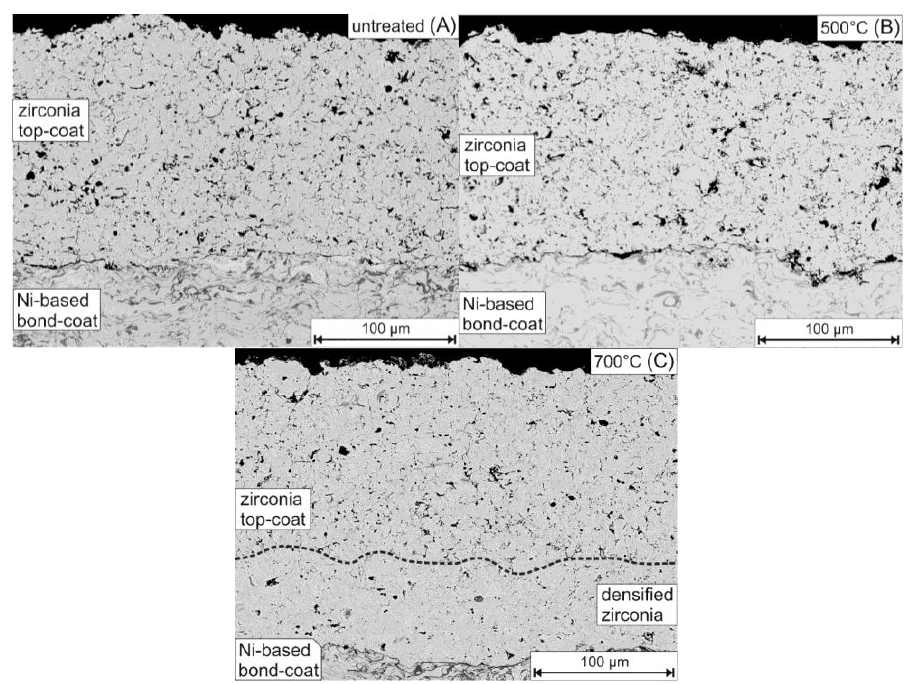
Figure 7. Back-scattered electron images of lab-scale experiment samples: ( A ) as-sprayed, untreated sample (LS 3); ( B ) sample treated for 2 days at 500 °C (LS 1); and ( C ) sample treated for 2 days at 700 °C (LS 2), showing a modified, less porous area of the zirconia top-coat, next to the nickel-based bond-coat.